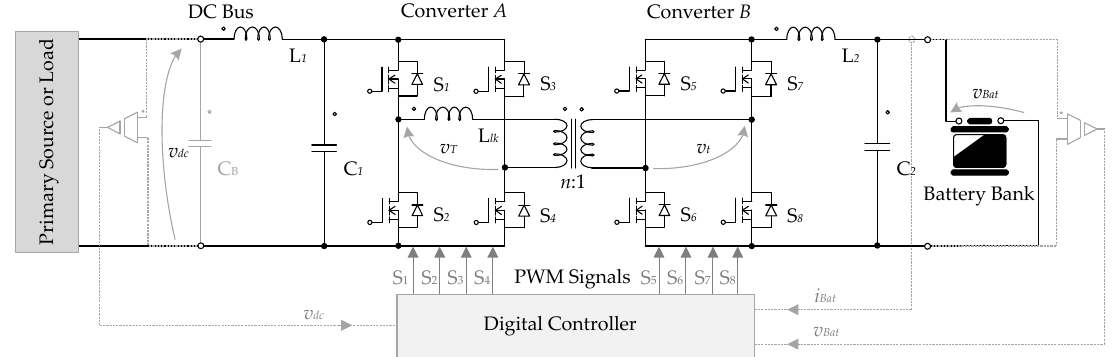
Figure 2. The power circuit diagram, instrumentation, and control of the proposed current-fed dual active bridge (CFDAB) converter .